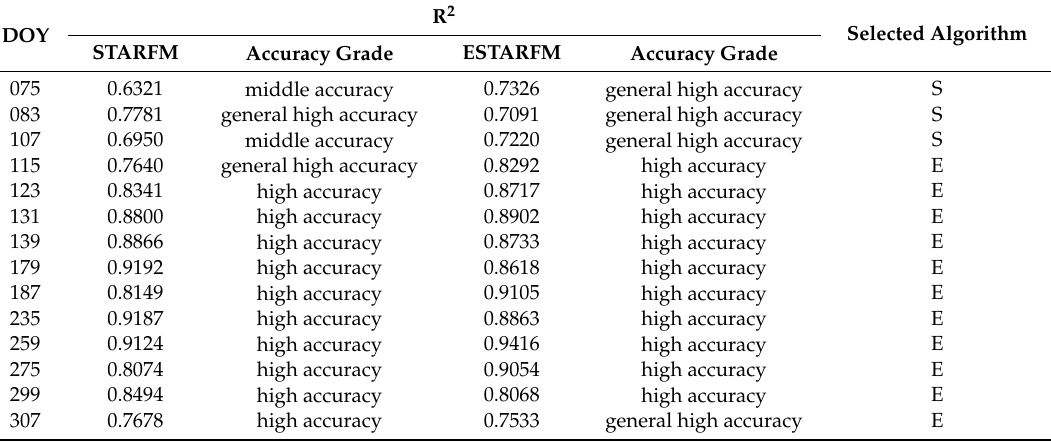
Table 3. Screening results of the spatio-temporal fusion algorithm in 2008 based on the regression equation of spatiotemporal variance and R2. DOY represents the day of year. R DOY